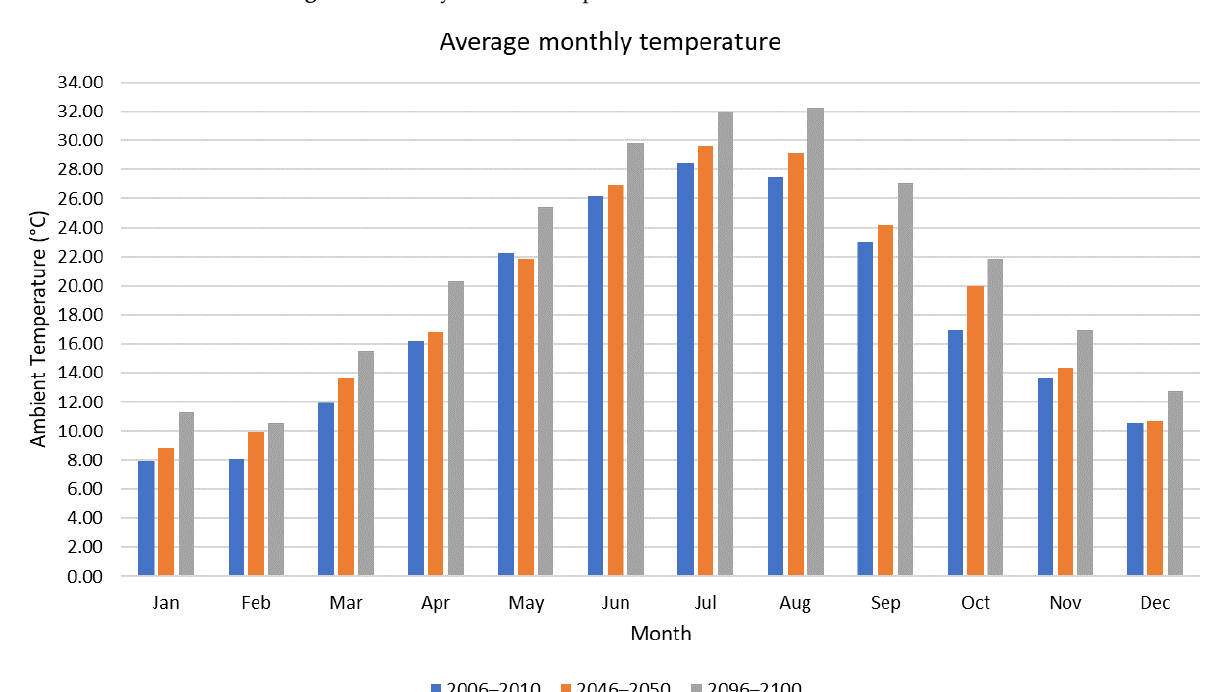
Figure 5. Average monthly ambient temperature.